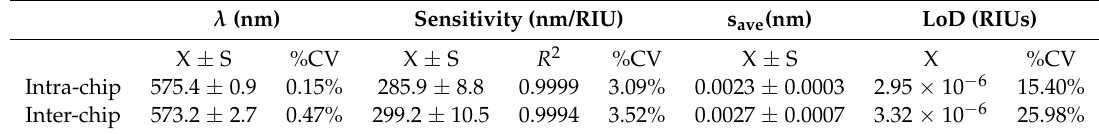
Table 2. Reproducibility of BICELLs response within one chip (intra-chip, number of samples = 11 BICELLs) and among different chips (inter-chips, number of samples = 11 BICELLs × 20 sensor chips = 220). LoD or resolution was calculated according to Equation (1) where sample size n = 66 in all cases.